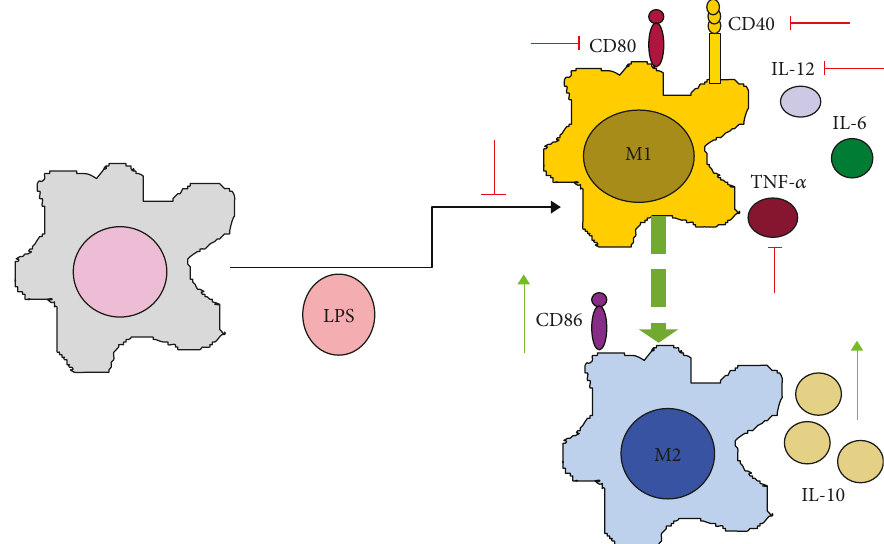
Figure 2: VPA induces M1-M2 polarization of macrophages in response to LPS. VPA polarizes macrophages from the M1 to the M2 immune phenotype in response to the stimulation with LPS by changing the cytokine pro fi le (IL-12, IL-6, and TNF- α are reduced, while IL-10 increases), as well as the pattern of costimulatory molecules (from CD80 to CD86, and inhibiting CD40 expression). Green arrows indicate the processes, molecules, or mediators in the signaling pathway that are augmented and/or promoted by VPA. Red arrows indicate processes, molecules, or mediators in the signaling pathway that are inhibited by VPA.